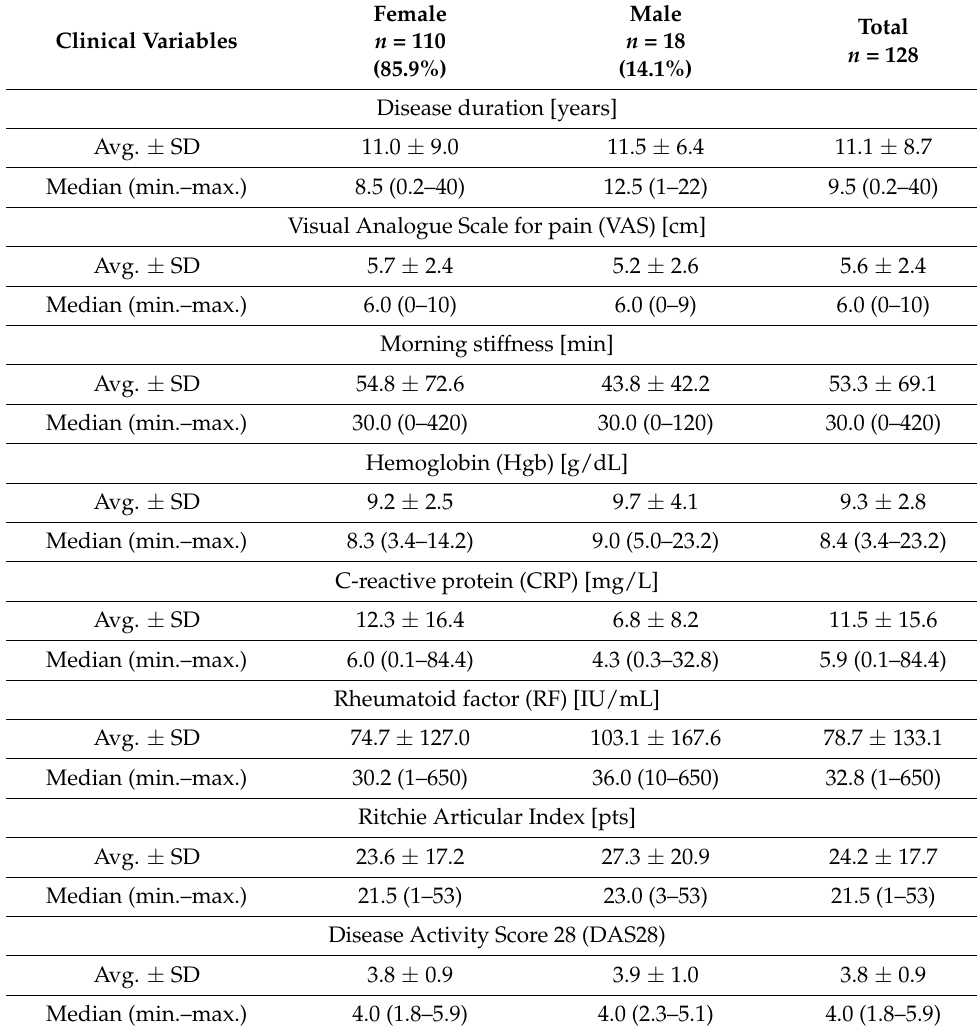
Table 2. General characteristics of the participants for clinical variables.